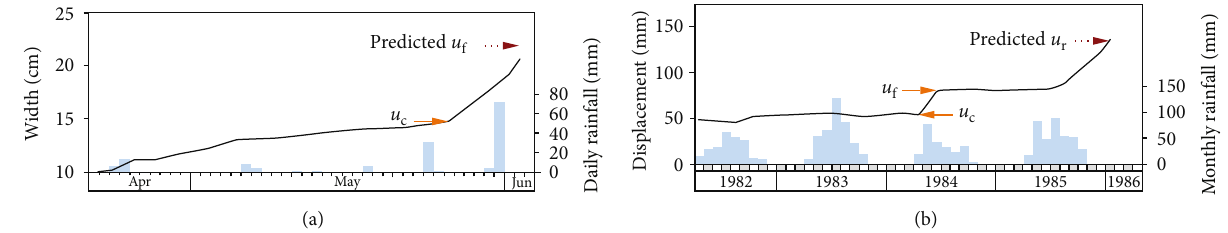
Figure 2: Displacement – time curves of the (a) Yanchihe [7] and (b) Longxi slopes [8]. The blue bars are the rainfall